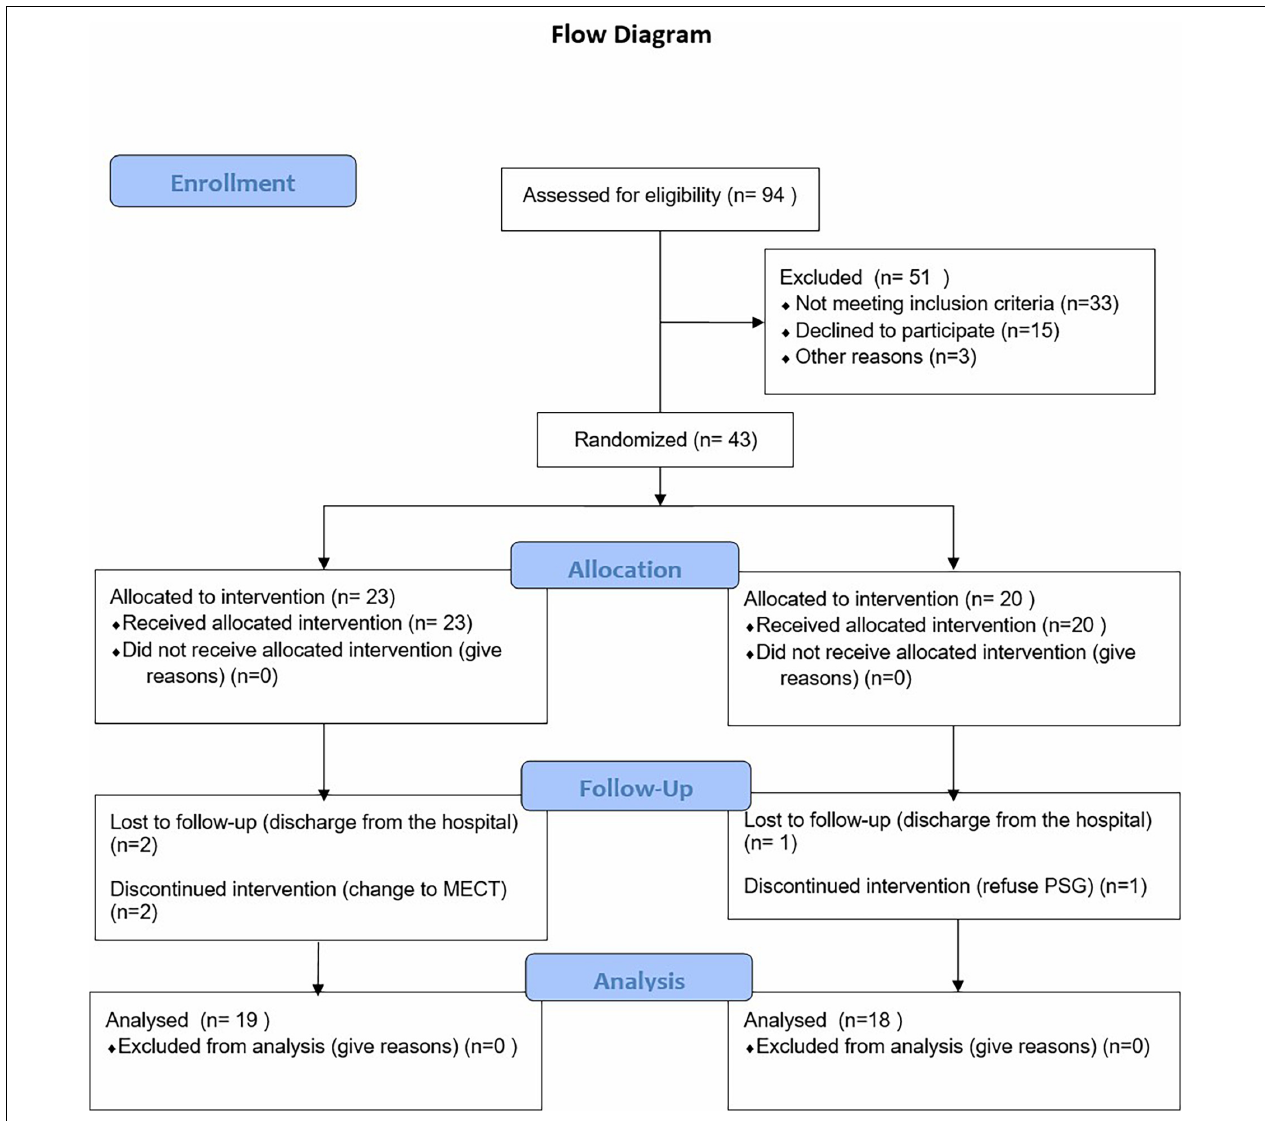
FIGURE 1 | Flow diagram of the progress through the phases of a parallel randomized trial of two